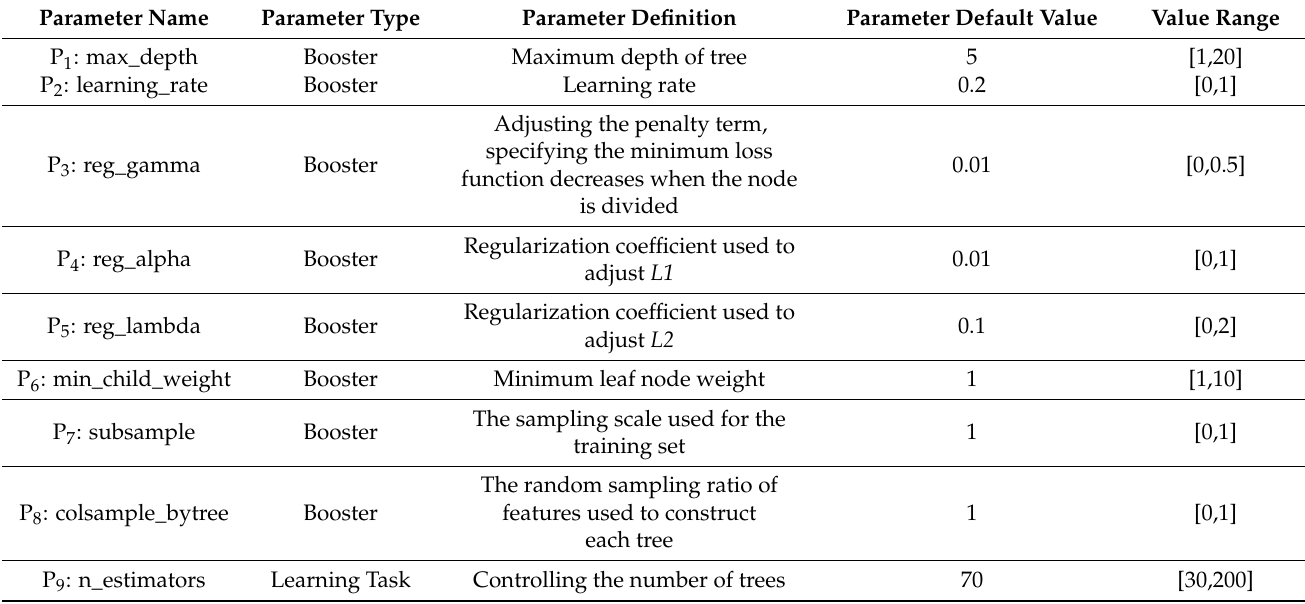
Table 2. Optimized parameters and value range of XGBoost.